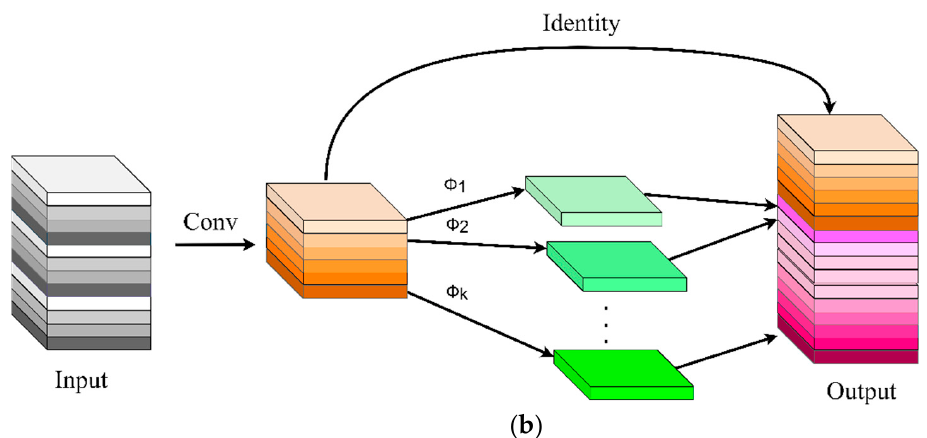
Figure 3. Ghost module, normal Conv is shown in ( a ) and Ghost Conv is shown in ( b ). We have replaced the C3 module with C3Ghost and replaced the Conv module with GhostConv, as is shown in Figure 4. The linear operation is a group convolution [28], as is shown in Figure 5. In some cases, group convolution can indeed bring about better model results than standard 2D convolution, because group convolution can increase the diagonal correlation between adjacent layer filters and reduce the training parameters. It is not easy to overfit, which is similar to the effect of regularization. In general speaking, the parameters p utilizes standard 2D convolution as is shown in Equation (4), and the parameters P (cid:48) is shown in Equation (5) with group convolution, where h 1 , w 1 , C 1 , C 2 , g are the filters height, the filters width, the input channels, the output channels and the number of groups, respectively. We can get similar feature maps with the 1/g times number of parameters.